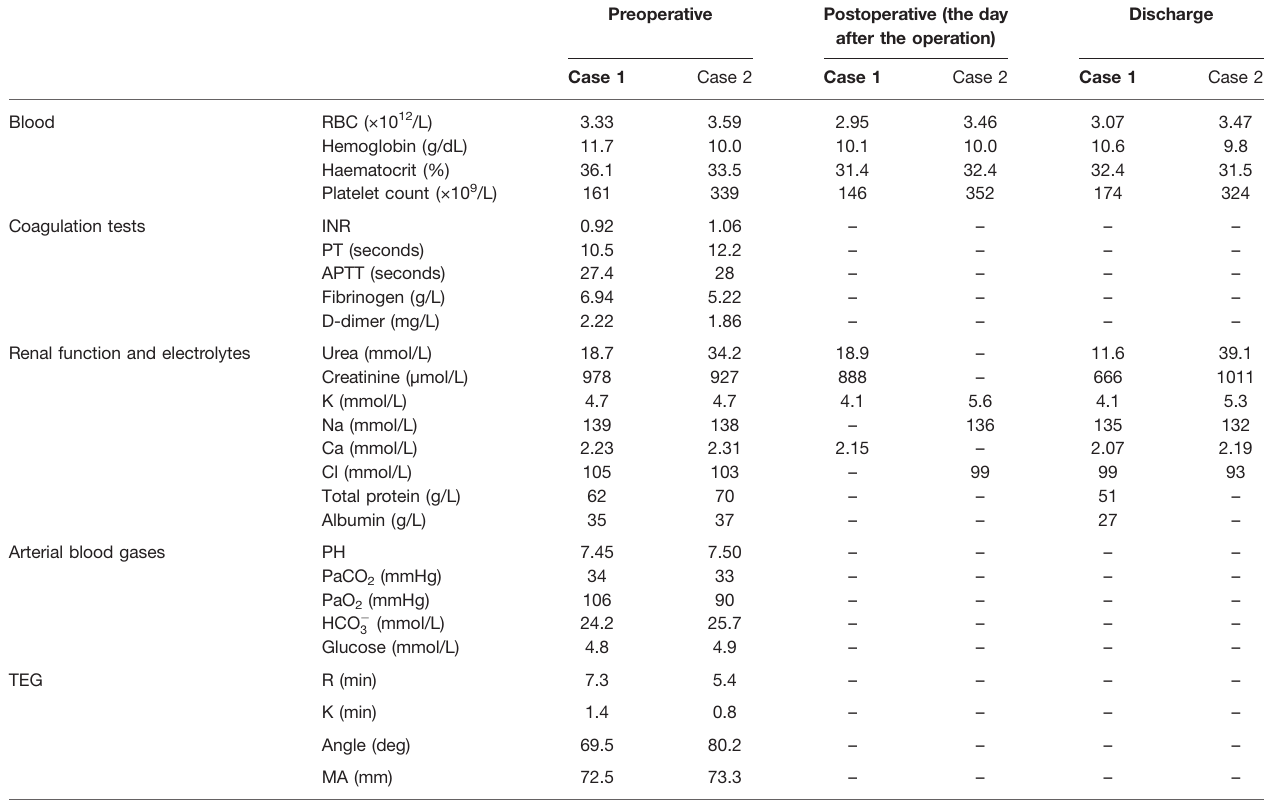
TABLE 1 | Preoperative, postoperative and discharge laboratory